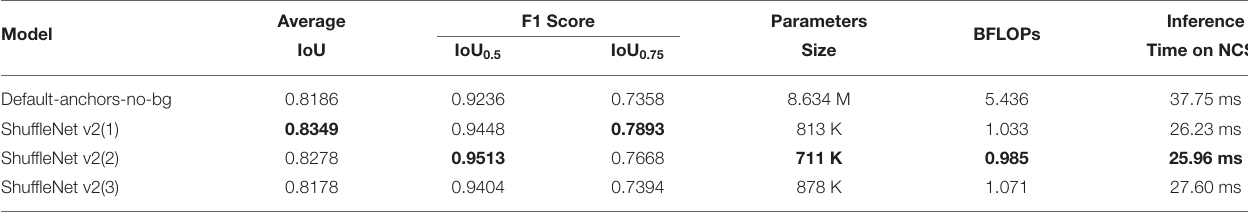
TABLE 7 | Performance data of ShuffleNet